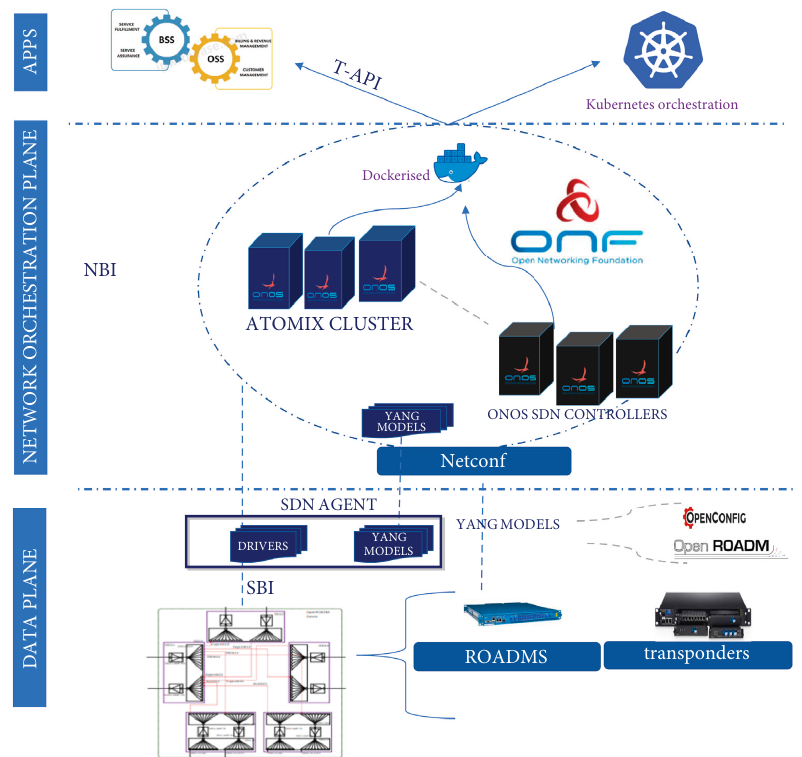
Figure 18: Proposed SDON architecture using ONOS clusterisation and multivendor